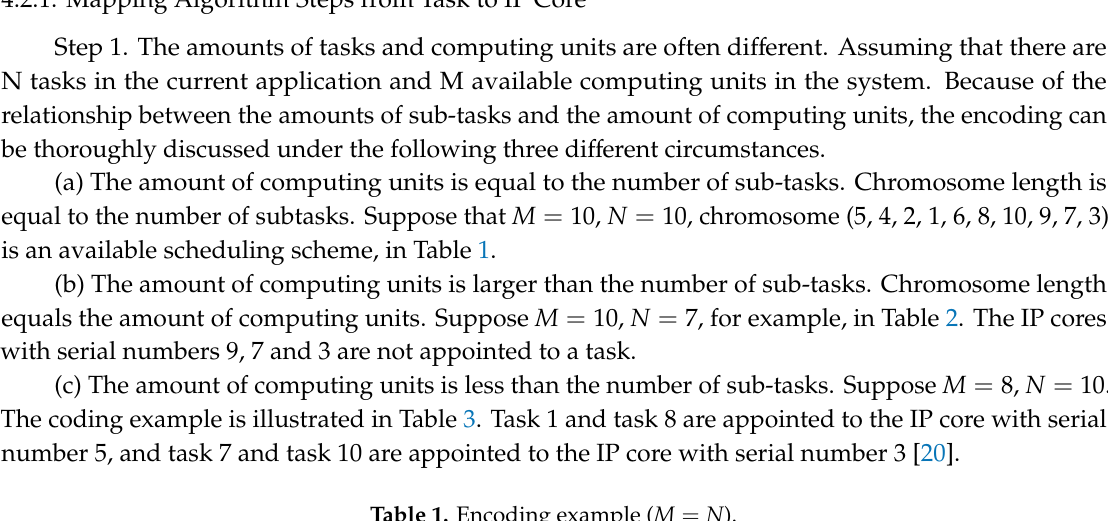
Table 1. Encoding example ( M = N ).